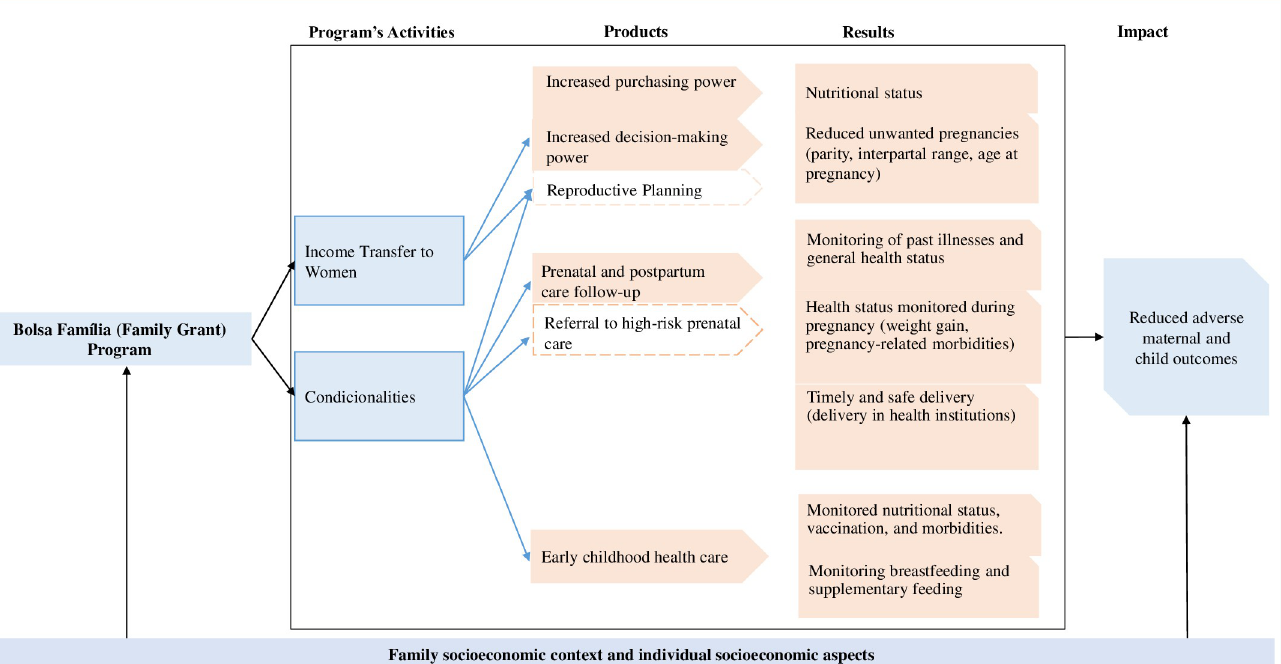
PLOS ONE | https://doi.org/10.1371/journal.pone.0268500 May 23,